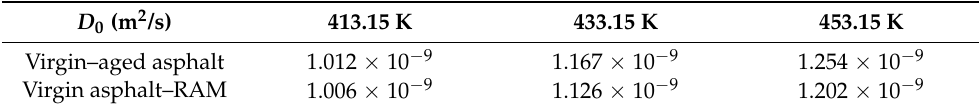
Table 4. Diffusion coefficients of virgin